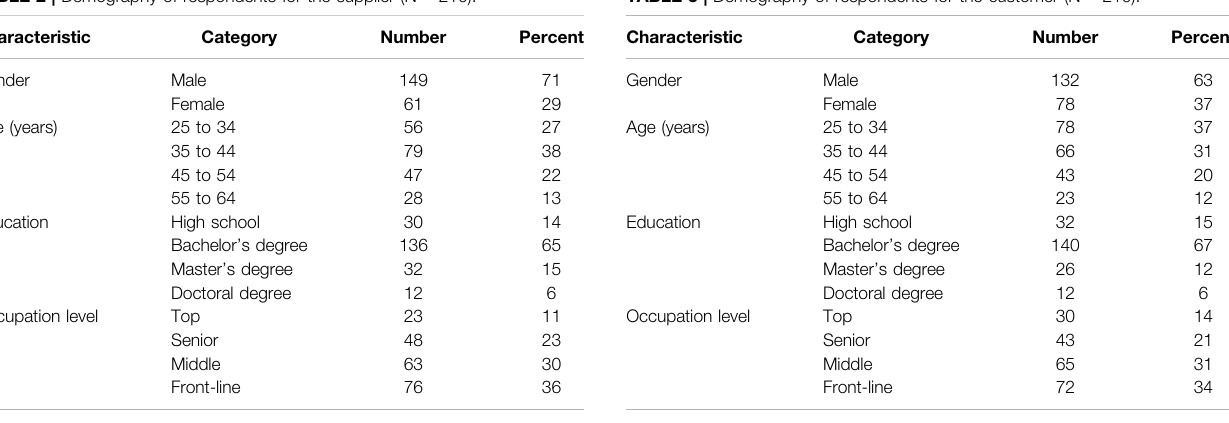
TABLE 2 | Demography of respondents for the supplier (N = 210). TABLE 3 | Demography of respondents for the customer (N = 210).